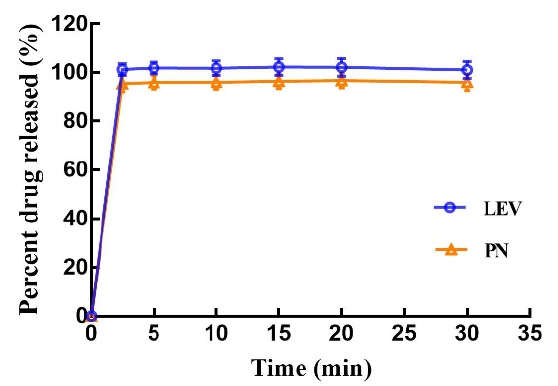
Figure 10. In vitro dissolution profile of the 3D-printed tablets; values are expressed as the mean ± SD, n = 6.